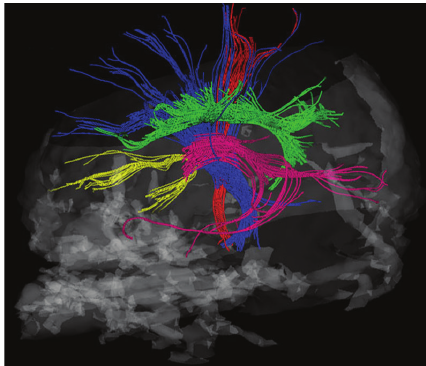
Figure 7: Spatial relation of the superior longitudinal fasciculus (green), the inferior longitudinal fasciculus (cyan), the optic radiation (purple), the uncinate fasciculus (yellow), and the inferior frontooccipital fasciculus